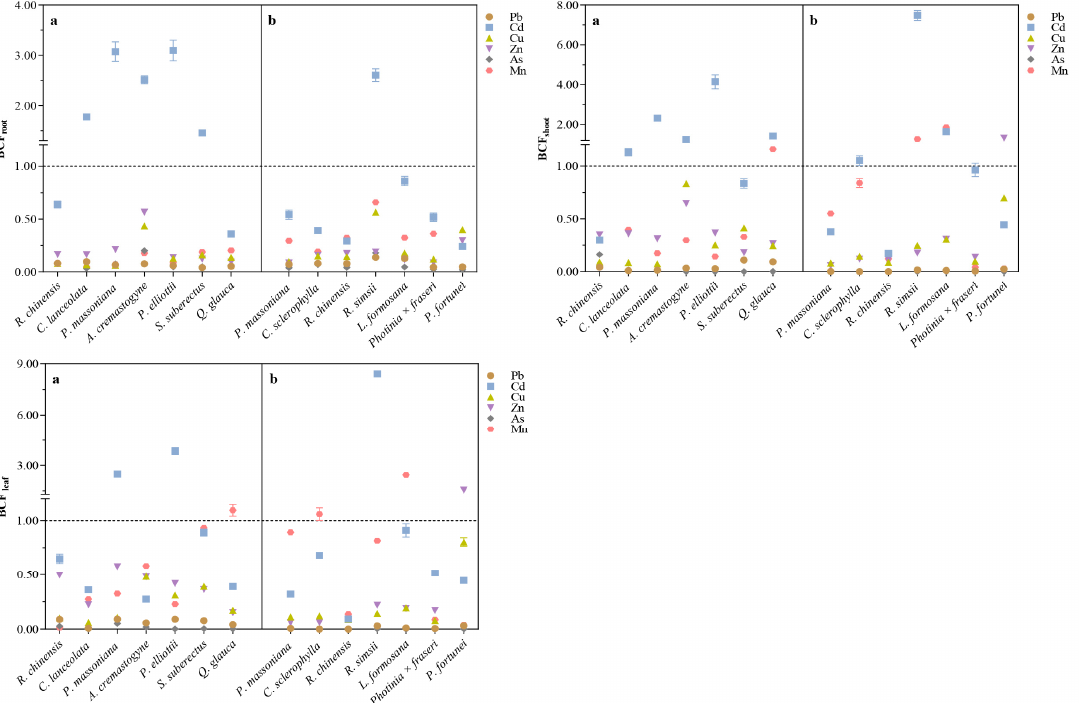
Figure 5. The loading plot from principal component analysis in selected samples from the Jiulong iron tailing area ( a ) and Yangtiangang lead − zinc tailing area ( b ).